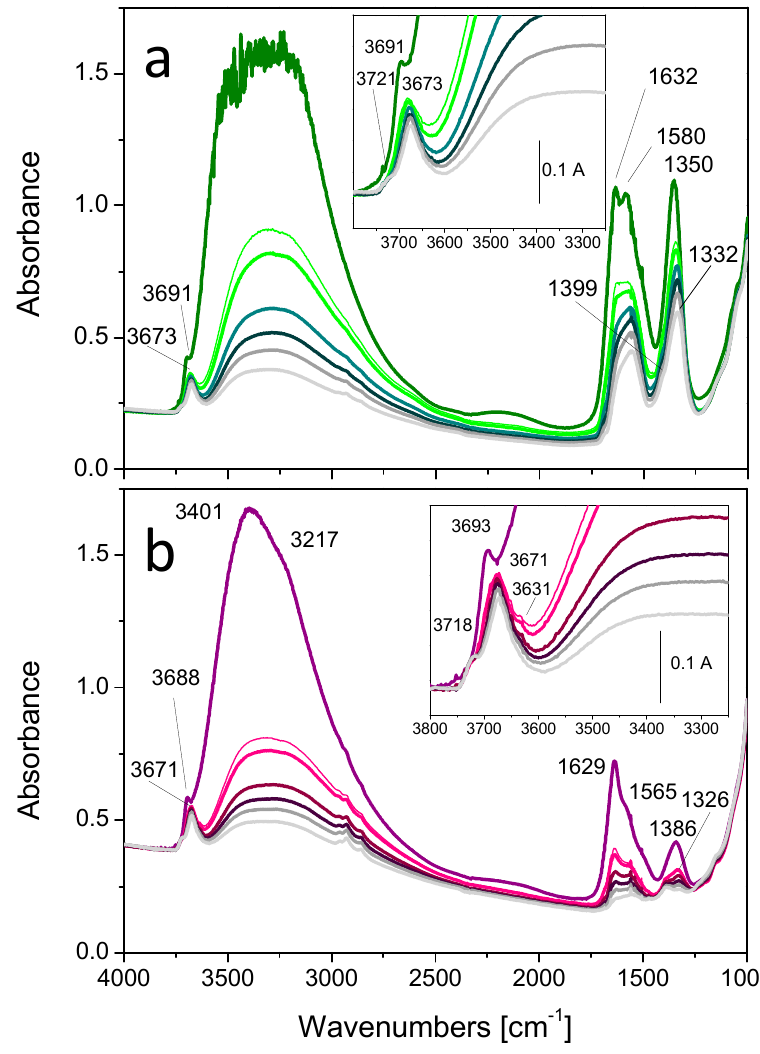
Figure 9. FTIR absorbance spectra of CuO ‐ TiO 2 ( a ) and Au ‐ TiO 2 ( b ) in air (olive/purple curves), under 10 min (fine green/pink curves) and 30 min (bold green/pink curves) outgassing at r.t., at 80 °C (cyan/wine curves), at 100 °C (dark cyan/wine curves), at 120 °C (dark grey curves), and at 150 °C (light grey curves).